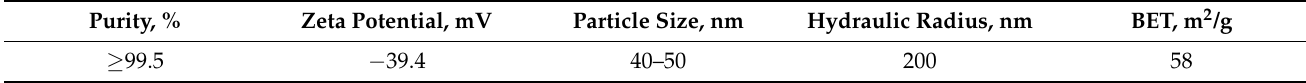
Table 1. The basic properties of ZnO